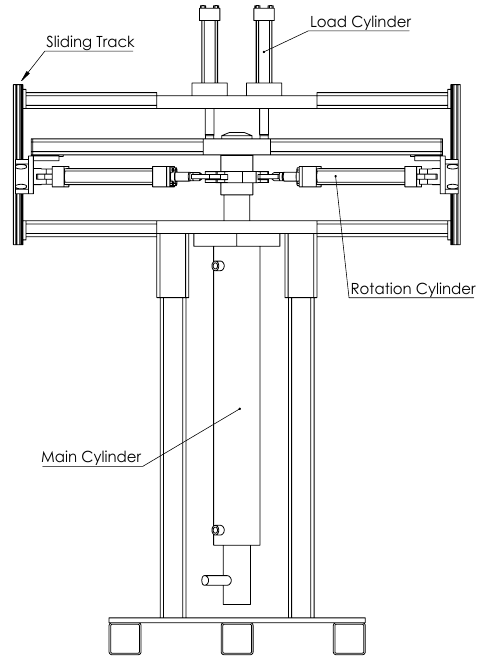
Figure 2: Overview of the experimental system.